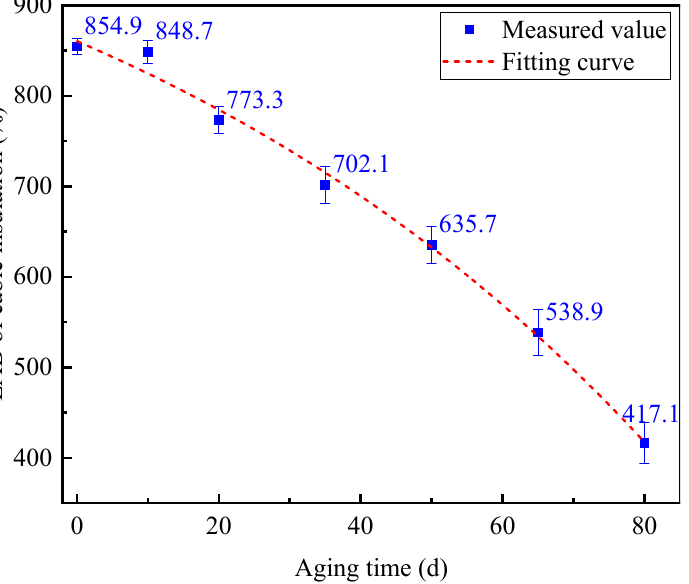
Figure 7. EAB and the corresponding variance of the aging middle cable insulation layer samples versus aging time.